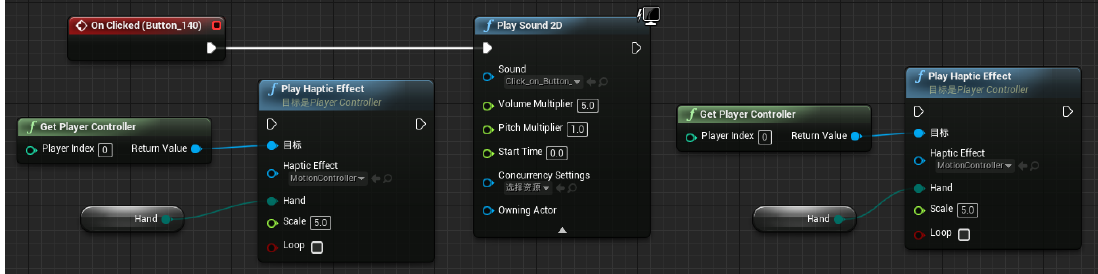
Figure 8. UE4 Sensory channel interactive experience coding blueprint.